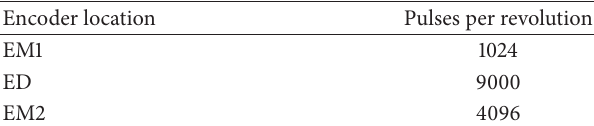
Table 1: Data of the